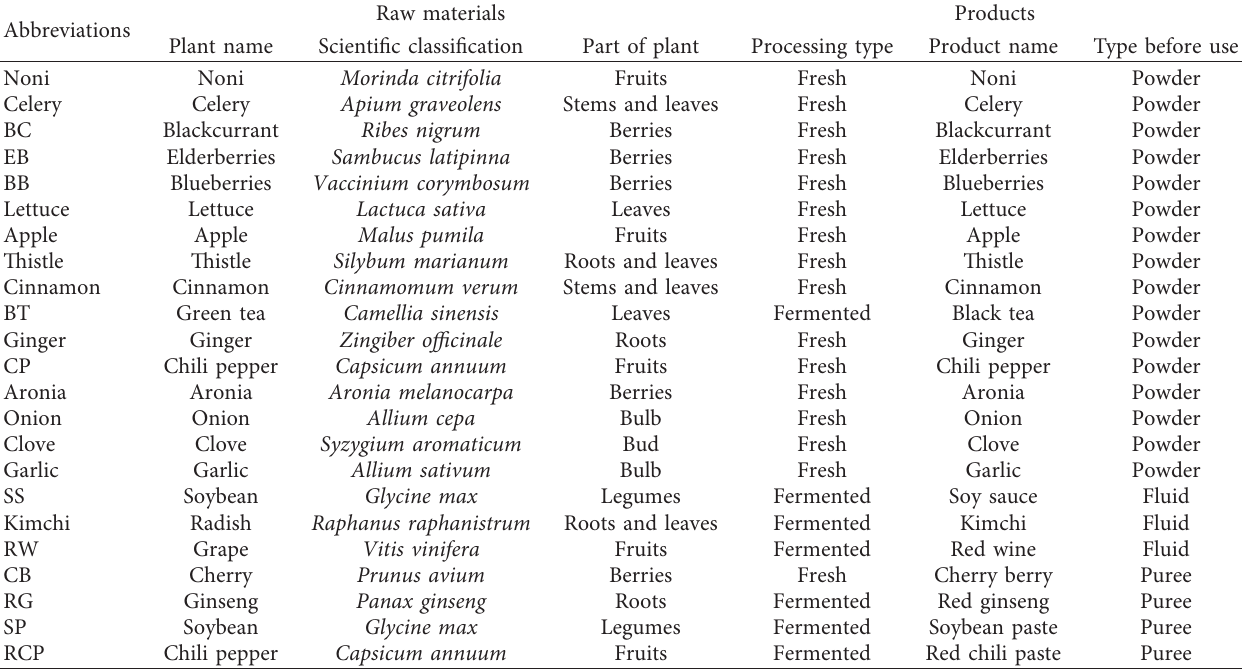
Table 1: Natural sources used as antioxidants in pork